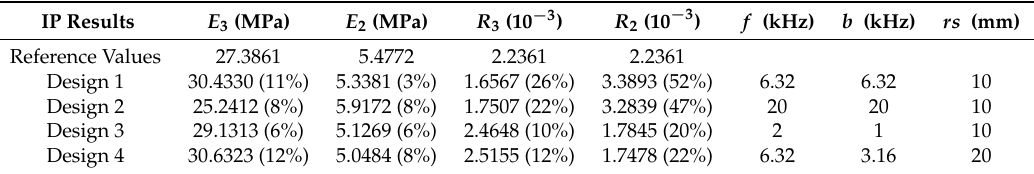
Table 5. Adjusted parameter for each set of excitation conditions including the relative error against reference values. Thus, Number 3 is the optimal design.